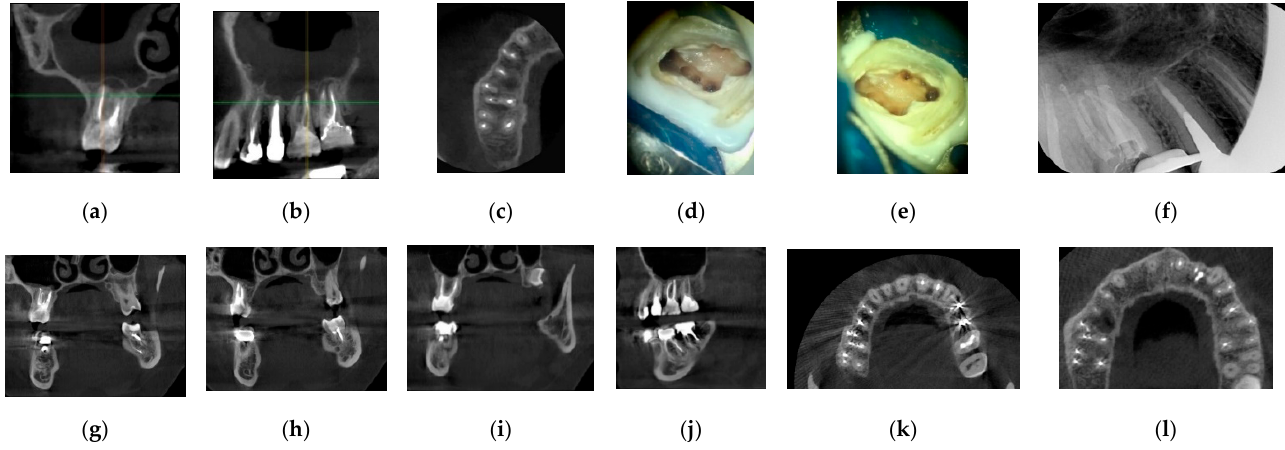
Figure 3. Clinical case 3. ( a ) CBCT (coronal section) with a periapical radiolucent lesion and mucosal thickening of the right maxillary sinus membrane. ( b ) CBCT (lateral section) with a periapical radiolucent lesion and mucosal thickening of the right maxillary sinus membrane. ( c ) CBCT (axial section) with a radiolucent area visible on the first right maxillary molar. ( d , e ) Tooth appearance after instrumentation of the root canals. ( f ) Final periapical radiographic after the retreatment. ( g – i ) CBCT follow-up after 11 months (coronary section). ( j ) CBCT follow-up after 11 months (lateral section). ( k , l ) CBCT follow-up after 11 months (axial section).